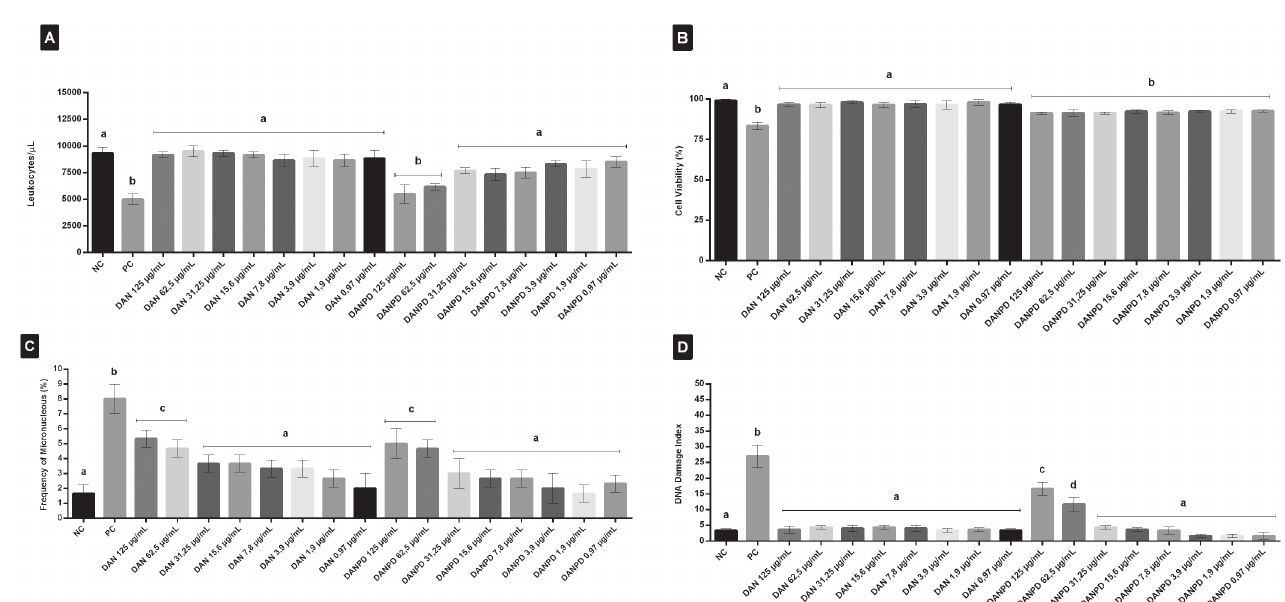
FIGURE 2 - Biological safety studies in cultures of human leukocytes: (A) Effects of DAN and DAN DP on cell proliferation; (B) Leukocyte evaluation of cell viability as measured by Trypan blue dye after exposure to different concentrations of DAN and DAN DP; (C) Comet Assay: Damage Index to DNA cells exposed to different concentrations of DAN and DAN DP; (D) Effects of DAN and DAN DP in the production of micronuclei in cell